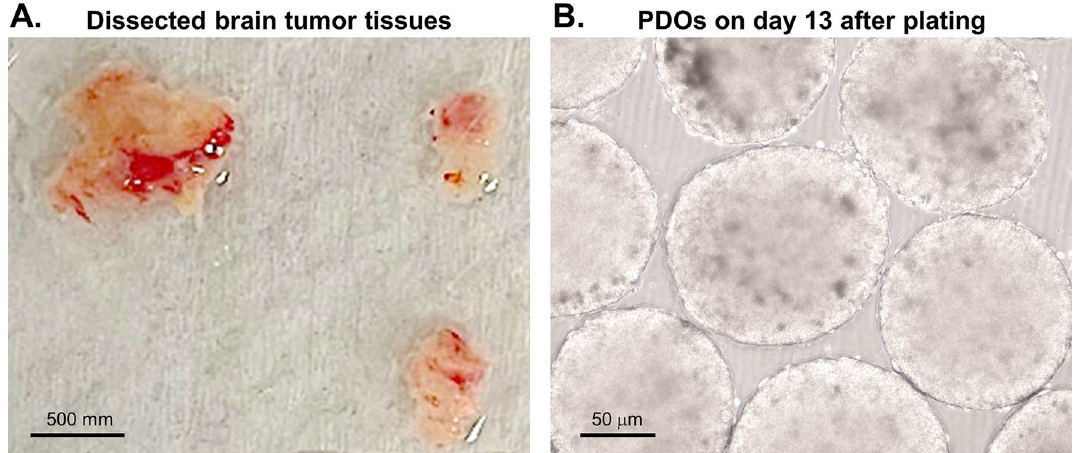
Figure 1. Generation of brain tumor organoids. ( A ) bright field image of dissected human brain tumor tissues. Scale bar, 500 mm. ( B ) Bright field image of representative organoids cultured for day 13 after receiving the specimen. Scale bar, 50 μm.